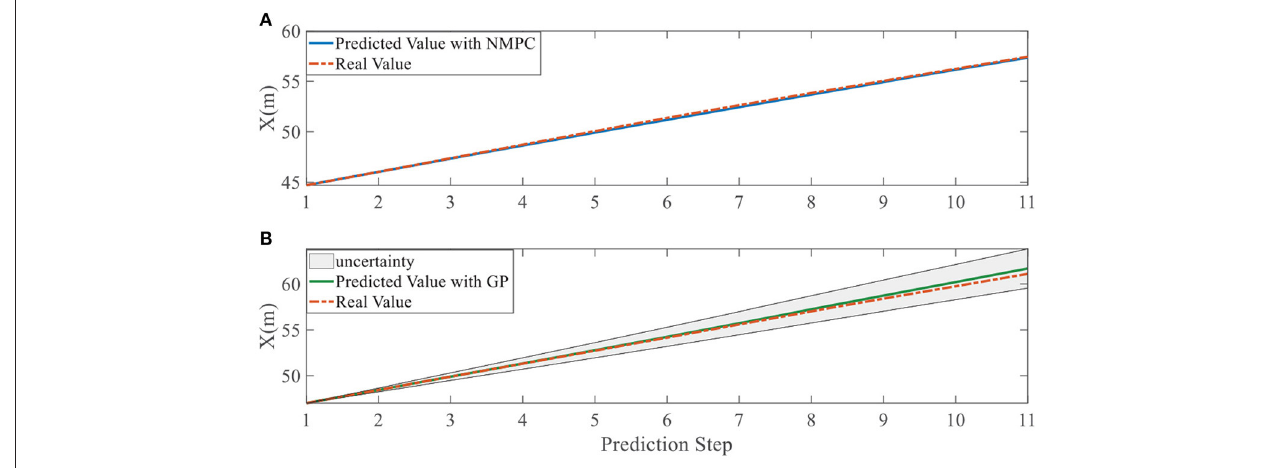
FIGURE 13 | Position X evolution in right overtaking. (A) NMPC; (B) GPMPC.